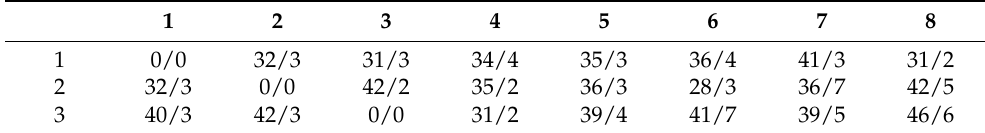
Table 3. The table of logistics costs and time consumption among various